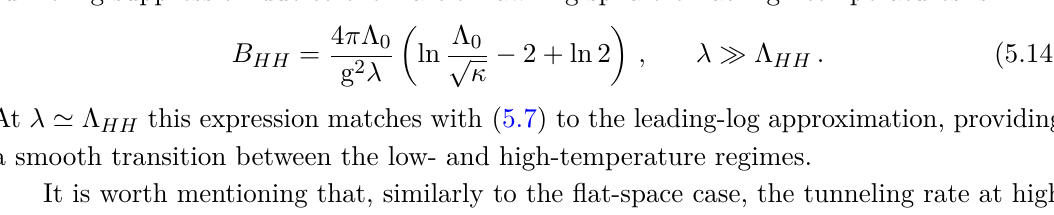
and B see eqs. (3.9), 0 M